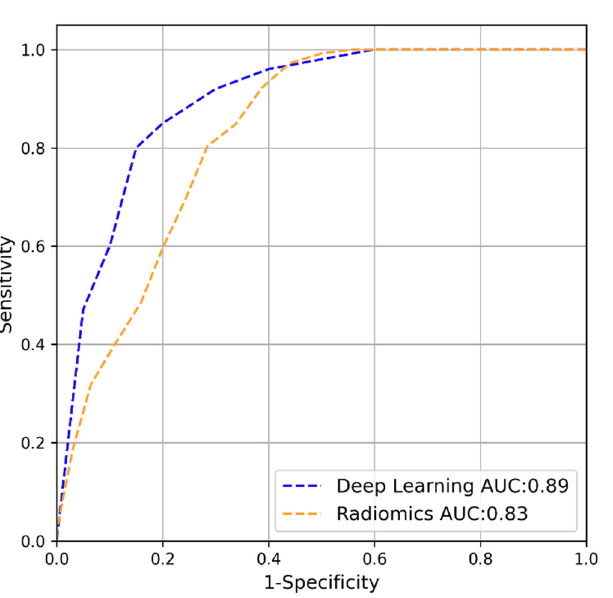
Figure 2. ROC curves of the deep-learning (blue) and radiomics (orange) models on the interval validation on Active Surveillance. Table 2. Deep-learning- and radiomics-model performances on the training set (Active Surveillance) and on the external sets (Prodrome, ProstateX and PCMM). DL : deep learning. AUC : Area under the curve.